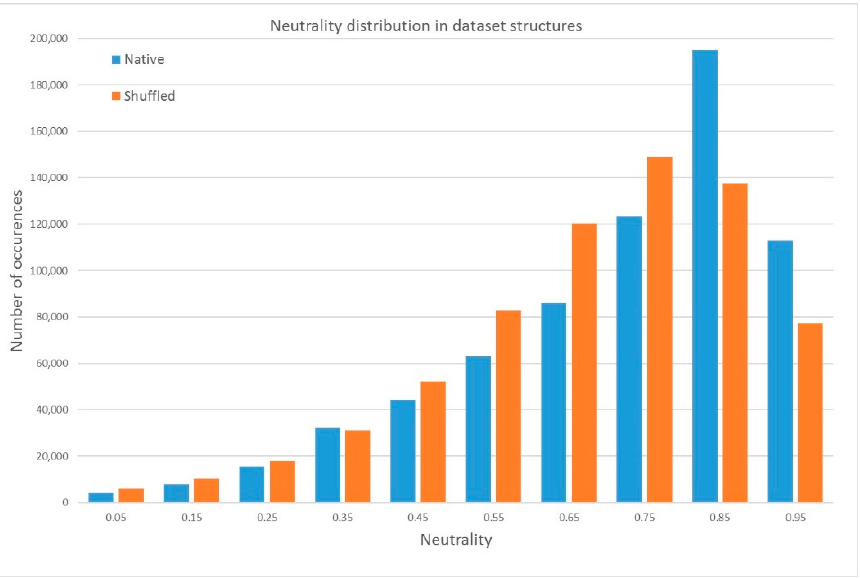
Figure 5. The neutrality distribution of all structures from our dataset comparing native and shuffled sequences. Reported p -value (see text) is less than 0.0001.